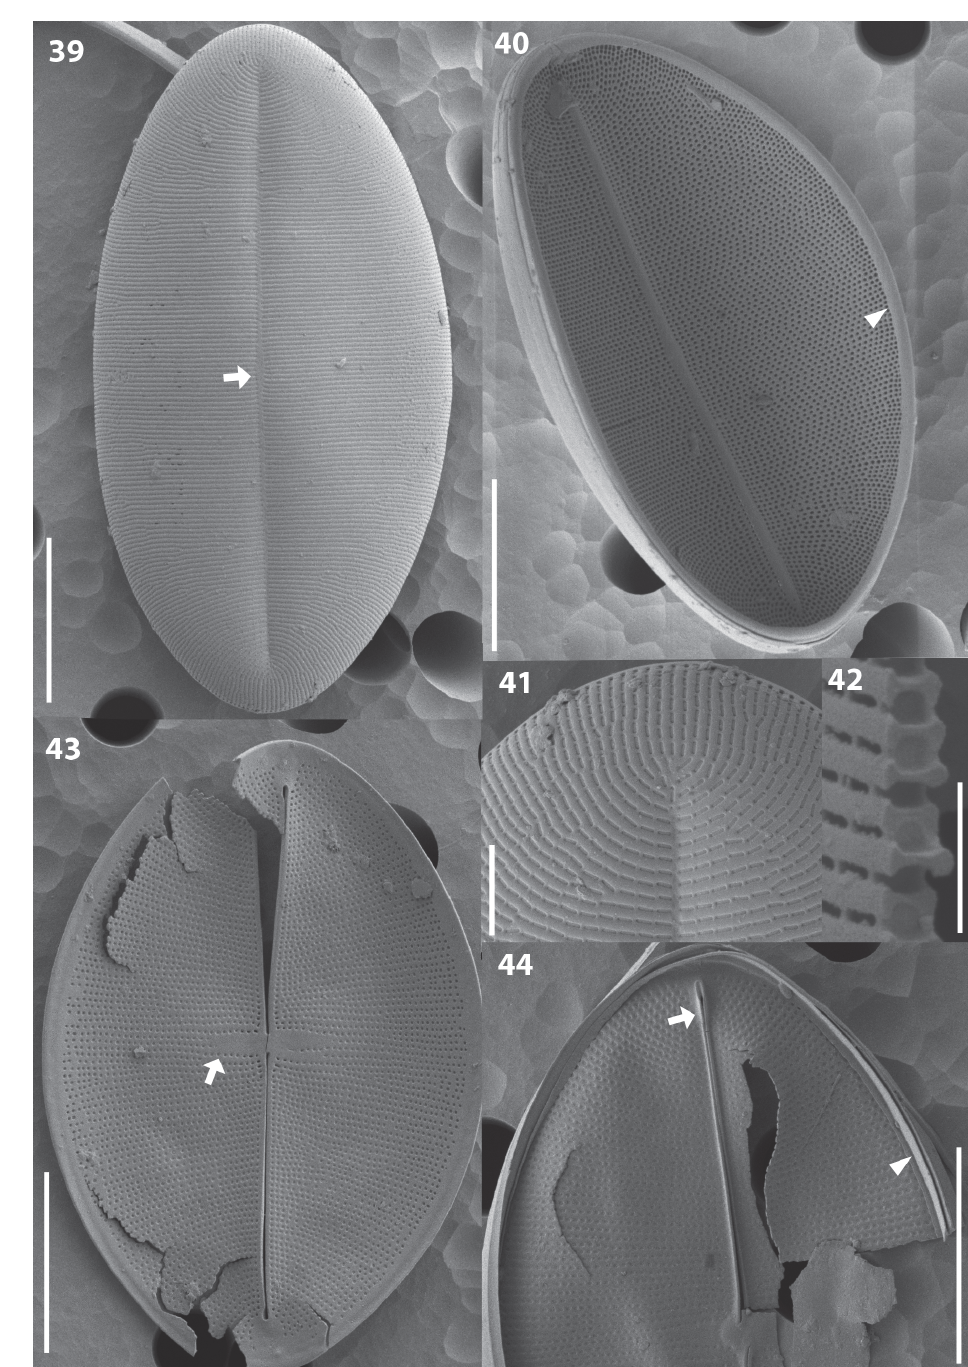
Figs 39–44. Cocconeis diaphana W.Sm. isolectotype SEM illustration. Mica labelled as “ Cocconeis diaphana n.sp., Jersey, Aug. 14. 1852”, deposited in the Van Heurck collection in Meise (BR). SV external view with a reduced central area (39, arrow) and striae composed of transversally elongated alveoli (39). SV internal view (40). Note the SV valvocopula (SVVC) with a smooth edge (40, arrowhead). Detail of the SV apex (41). Detail of a broken SV showing the double layered structure of the alveoli (42). RV external view with the central oblong-elongate central area reaching less than ⅓ of the valve width (43, arrow). RV internal view with a low and straight helictoglossa (44, arrow) and the RV valvocopula (RVVC) with a smooth edge (44, arrowhead). Scale bars = 10 µm (39, 40, 43–44), 2 µm (41), 1 µm